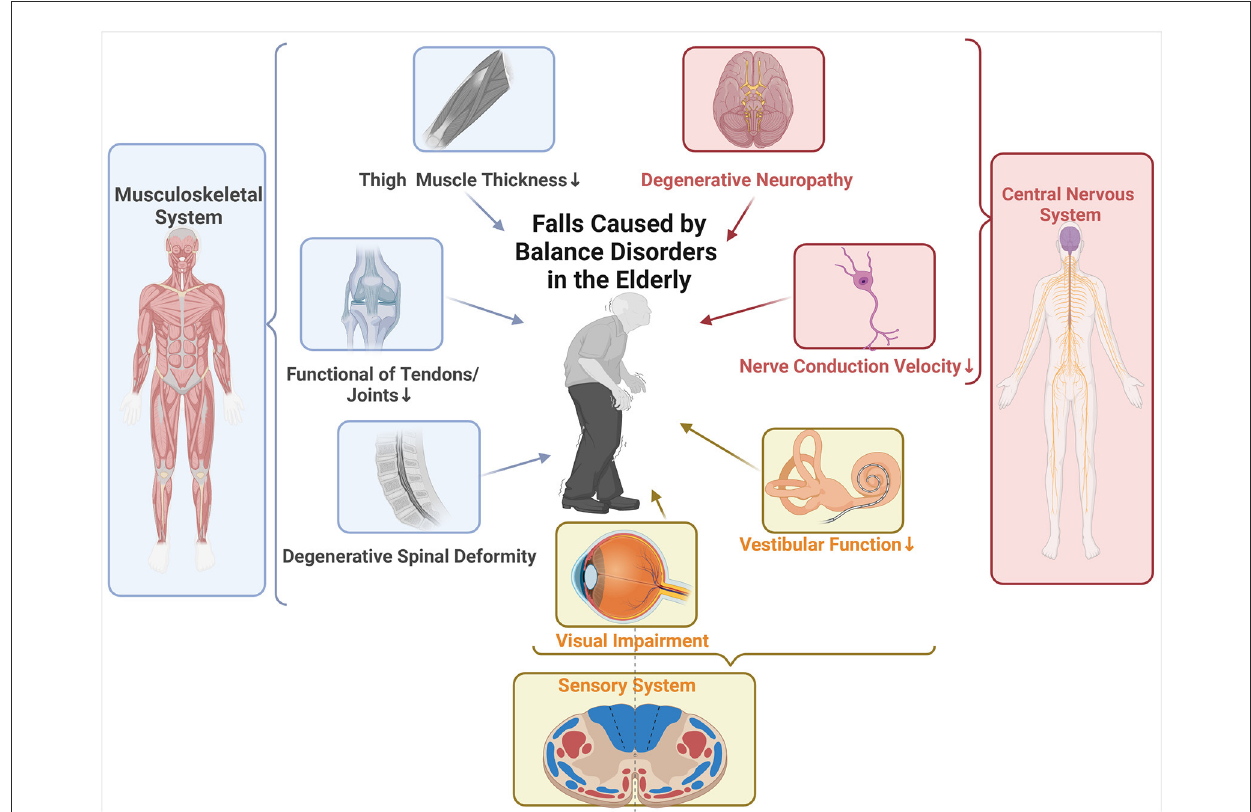
FIGURE1 Summary of pathogenic factors with multiple systems involved in falls caused by balance disorders in the elderly. Musculoskeletal system: In the elderly, decreased thigh and core muscle thickness is favorably connected with dynamic balance and correlated with fall risk. Functional degradation of tendons and joints occurs with aging, which is characterized by decreased muscle mass and reduced contractility, and thus leads to falls. Degenerative spinal deformity, which develops in the elderly due to accumulated degenerative changes brought on by aging, such as asymmetrical disc degeneration, dehydration, and collapse, combined with facet degeneration and ligamentous laxity, can significantly alter the body’s center of gravity and cause falls. Central nervous system (CNS): Aging brings about the spinal networks’ structural changes that impair their functionality and motor commanding. Unmyelinated fiber density decreases by 37% in the elderly, while myelinated fiber density decreases by 38%, which is the main culprit of elderly’s diminished nerve conduction velocity. Physical balance disorders and an elevated risk of falling are caused by the CNS’s degeneration, which makes it more difficult for the body to integrate motor signals. Sensory System: The visual system and vestibular system are like GPS and sentry mod. Older people with visual impairment have a higher incidence of falls than those without visual impairment. The decline